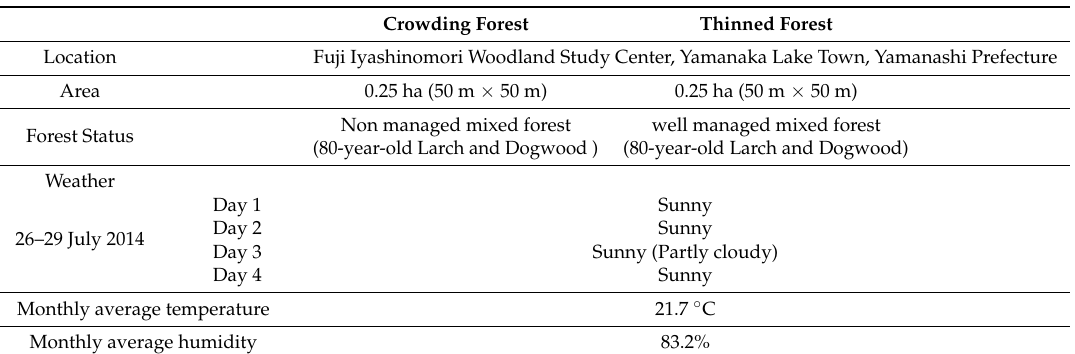
Table 1. Details of the research site.